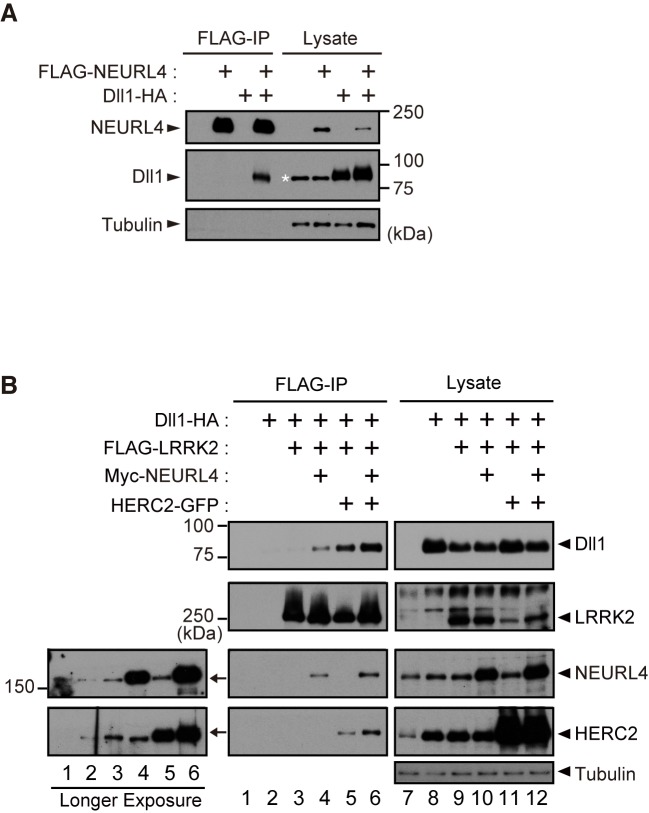
LRRK2, NEURL4 and HERC2 bind to the Notch ligand Dll1.(A) NEURL4 binds to Dll1. HEK293T cell lysate transfected with the indicated plasmids was subjected to immunoprecipitation with an anti-FLAG antibody and analyzed by Western blotting with anti-FLAG and anti-HA antibodies. The asterisk indicates non-specific bands that appeared with anti-HA (clone 12CA5). (B) LRRK2 associates with Dll1 via NEURL4 and HERC2. A co-immunoprecipitation assay was performed as in (A). Western blotting was performed with anti-Dll1, anti-LRRK2, anti-NEURL4 and anti-HERC2 antibodies. Longer exposures of X-ray films revealed endogenous proteins that co-immunoprecipitate with FLAG-LRRK2 (Left).